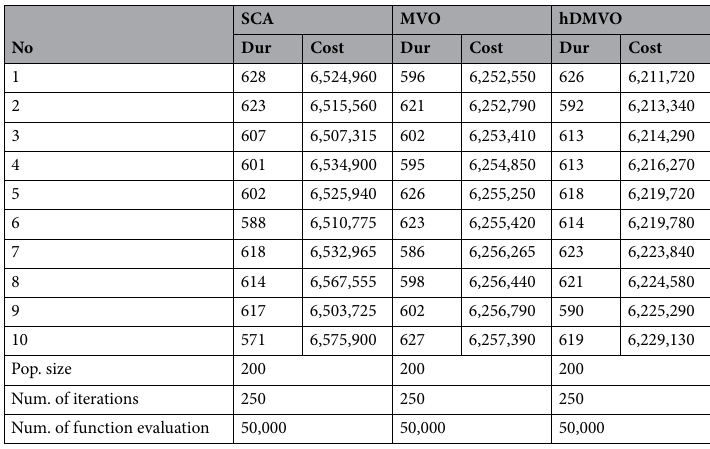
Table 10. Analysis results of problem